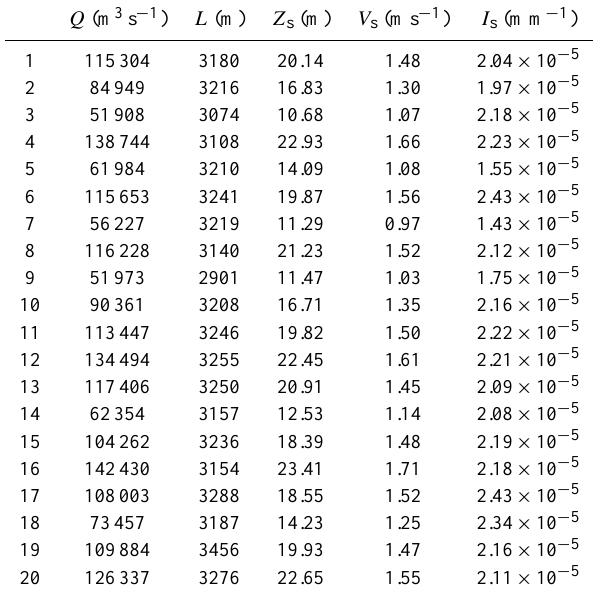
Table 1. Set of measurements at the Manacapuru gauging